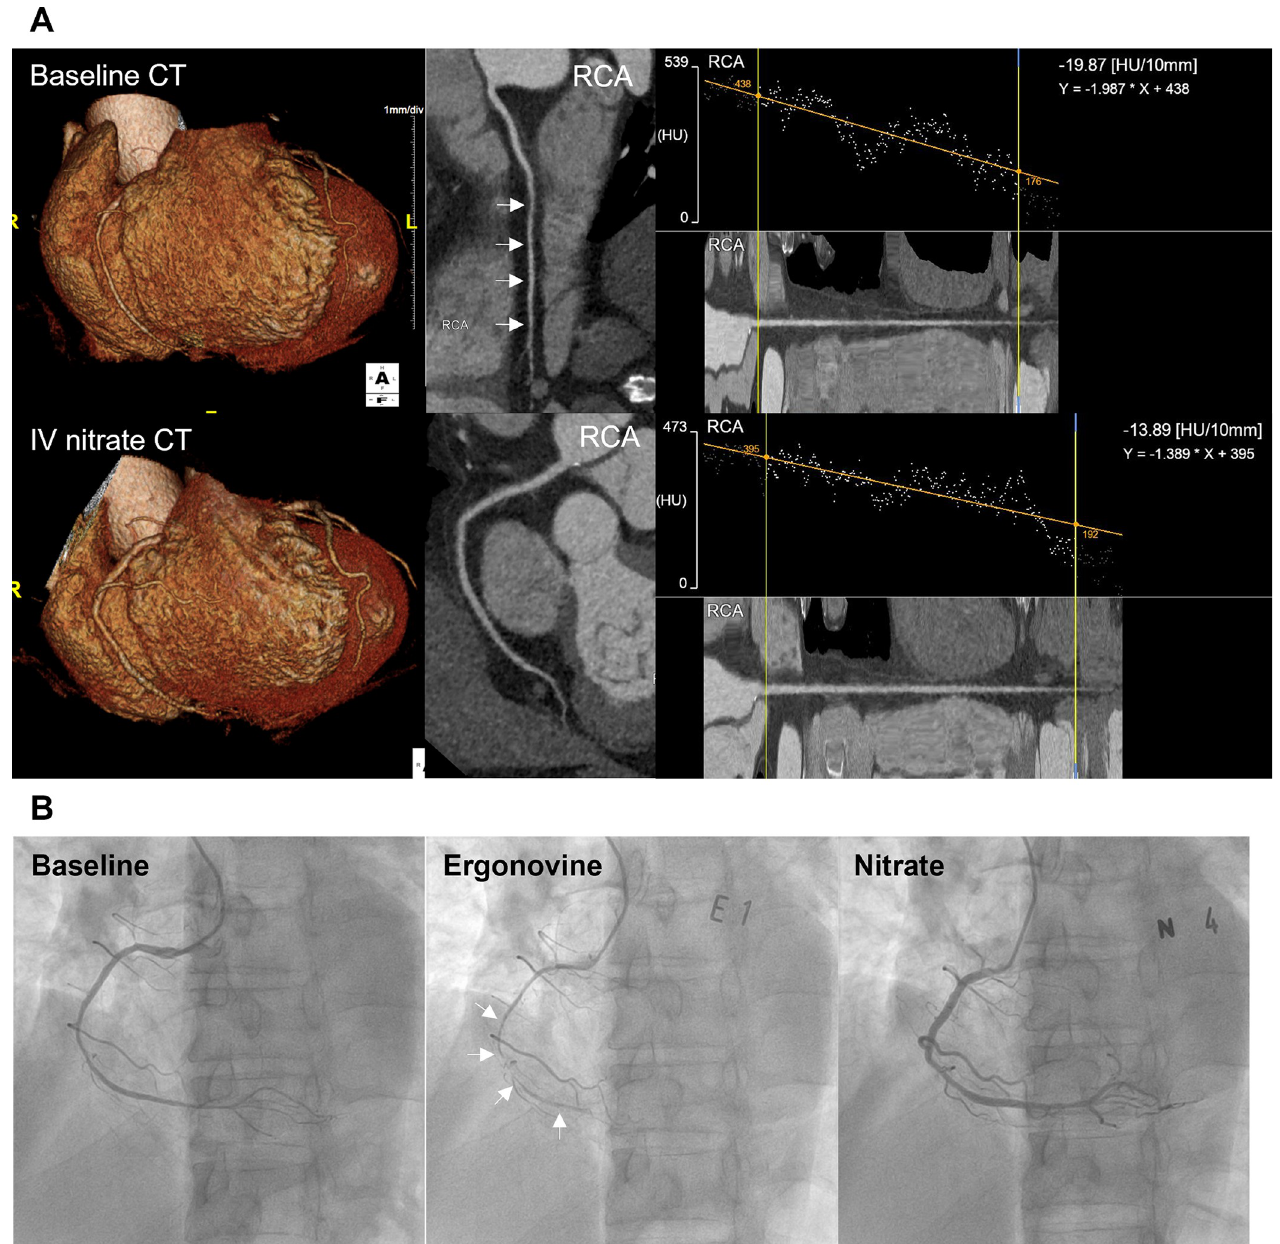
Fig 3. A representative case of the diffuse-type spasm on CCTA and the ergonovine provocation test. A 58-year-old male patient presented with chest pain. (A) Baseline CT (upper) revealed a diffuse small diameter with a beaded appearance throughout the coronary arteries at the distal RCA on volume rendering and curved multiplanar images. IV nitrate CT (lower) showed completely dilated coronary arteries without narrowing. (B) Baseline coronary angiography (left) demonstrated diffuse narrowing of the whole coronary branches, which was consistent with the findings on baseline CCTA (A). The TAG values were -19.87 and -13.89 on baseline CT and IV nitrate CT, respectively. CCTA, coronary computed tomography angiography; CT, computed tomography; IV, intravenous; RCA, right coronary artery; TAG, transluminal attenuation